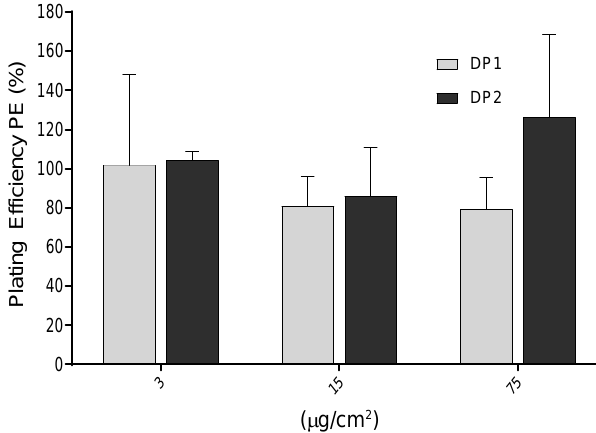
Figure 4. Cytotoxic e ff ects of TiO 2 NPs measured by the plating e ffi ciency (PE %) in V79-4 cells. Bars represent cytotoxicity relative to 100% of untreated cells Data are expressed as the means ± SEM of two parallel seedings for plating e ffi ciency, according to the used procedure. No statistical significances between exposed and unexposed cultures were